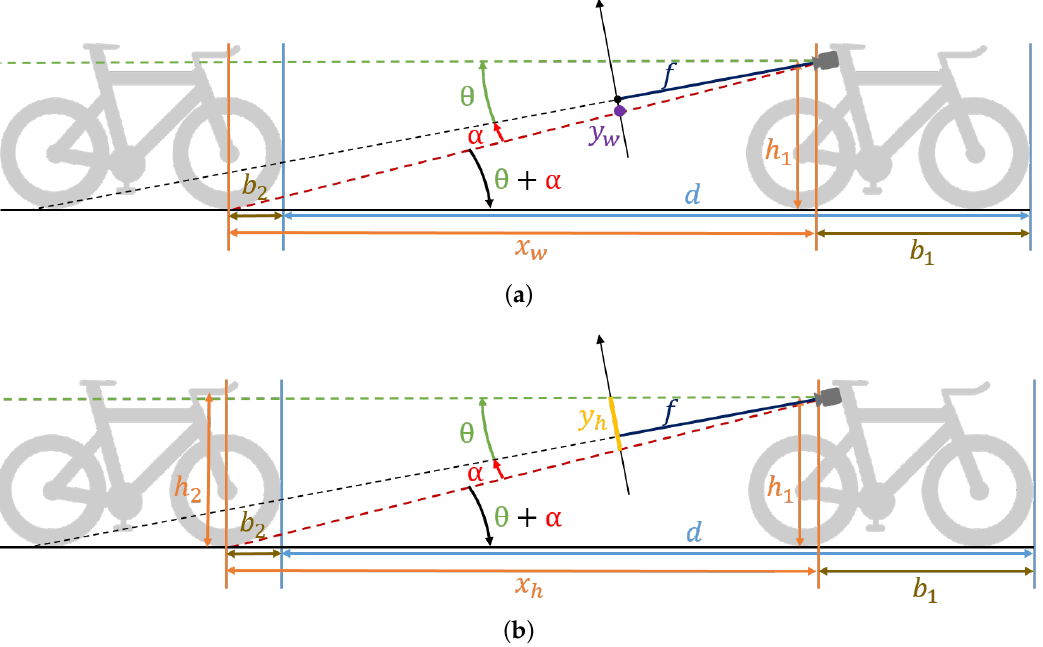
Figure 5. Demonstration of how the distance can be computed from the position of the bounding box. The distance d between the two athletes is measured between the leading edges of their bicycles’ front wheels. In the proposed methods, we estimate the distance x = x w = x h , which differs from d by a fixed constant distance ( b 1 − b 2 ) . This figure was modified from References [20,21]. ( a ) Wheel Position-Based method (WPm), estimated from y w ; ( b ) Handlebar Height-Based method (HHm), estimated from y h